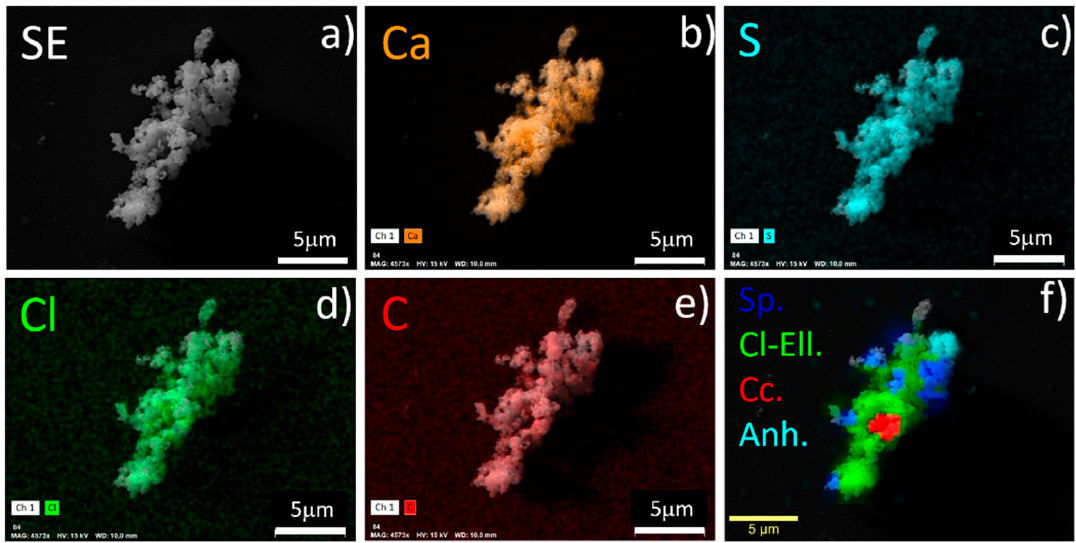
Figure 10. Electron microphotographs showing SE images of an aggregate of the sample HT[D2]_800 ( a ), the elemental distribution of Ca ( b ), S ( c ), Cl ( d ), and C ( e ). Superimposed Raman and SE image of the phase distribution of spurrite, ellestadite, calcite, and anhydrite ( f ).